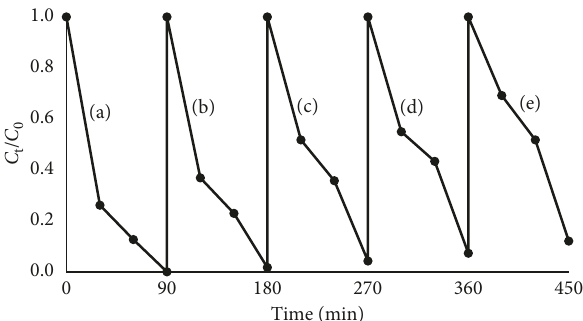
Figure 11: Photocatalytic recycling of Fe-C-TiO decomposition: first cycle (a); second cycle (b); third cycle (c); fourth cycle (d); fifth cycle